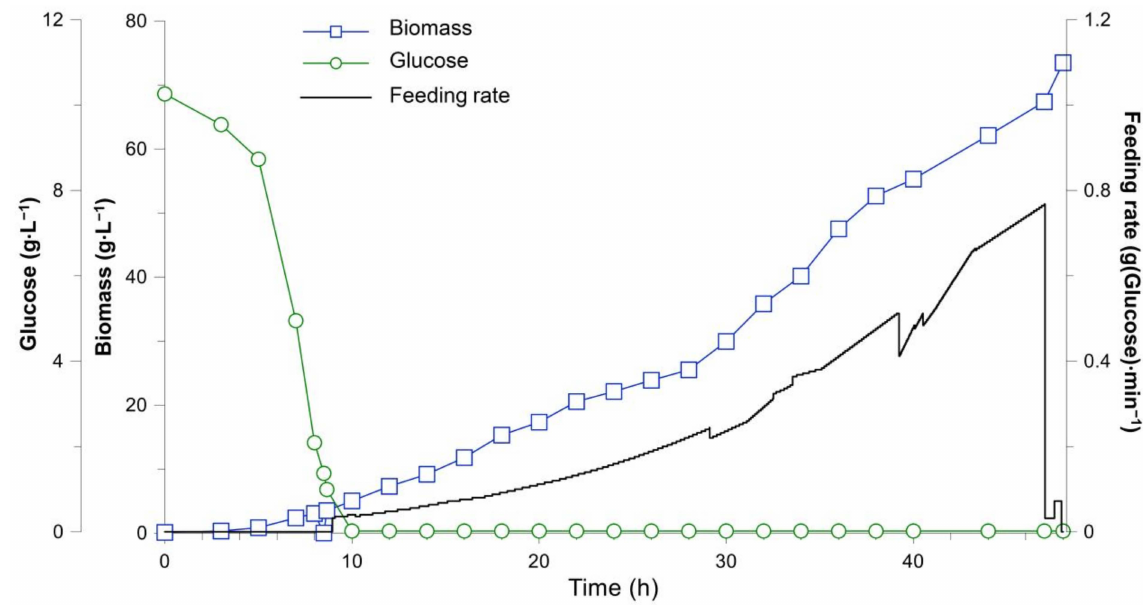
Figure 14. Cell growth and substrate feeding dynamics during yeast K. marxianus bioreactor cultiva- tion. The MPC system maintains the cell growth trajectory close to the reference growth profile with limited glucose accumulation in the medium, improving process yield and